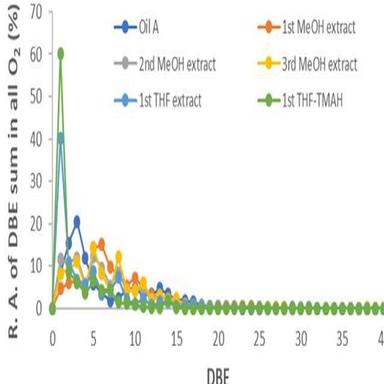
Possible layered distribution of acidic CxHyO2 species on reservoir rock.